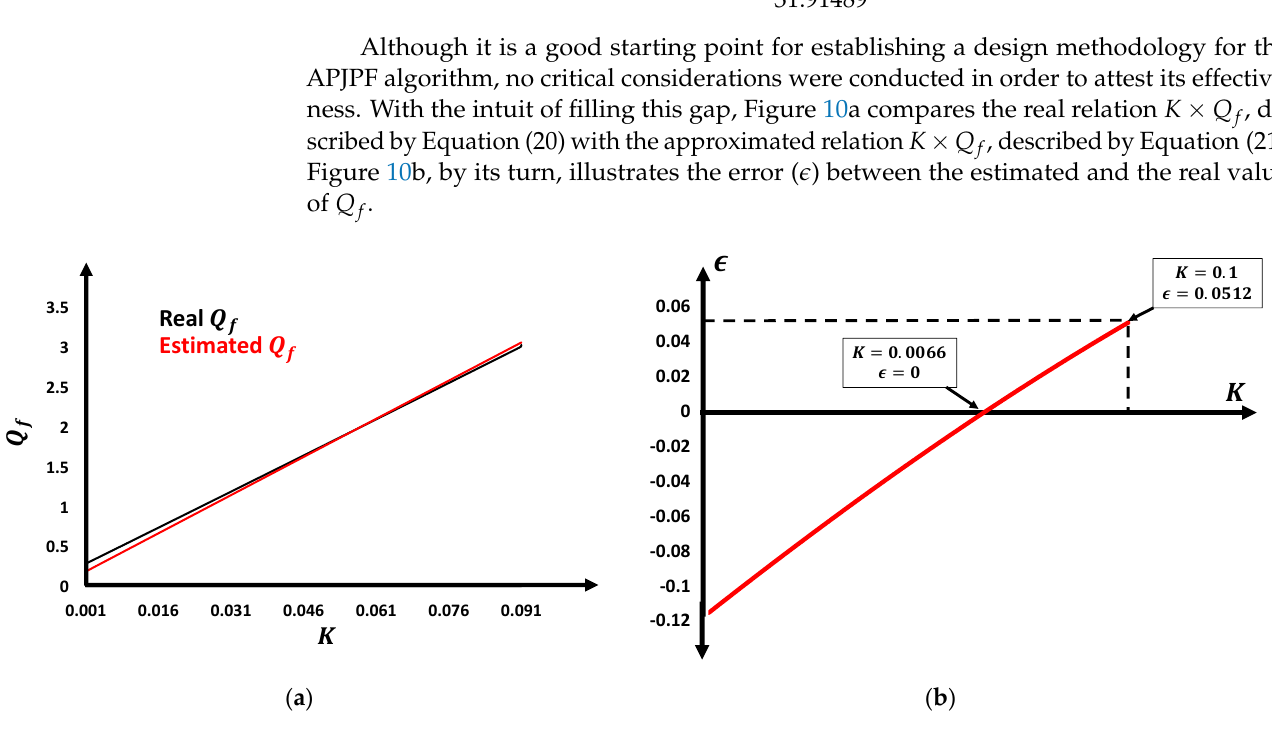
Figure 10. Analysis of the parametrization criterion proposed by [25]: ( a ) Comparison of the real with the estimated value of 𝑄 𝑓 ; ( b ) error of the approximation (21) in function of 𝐾 .